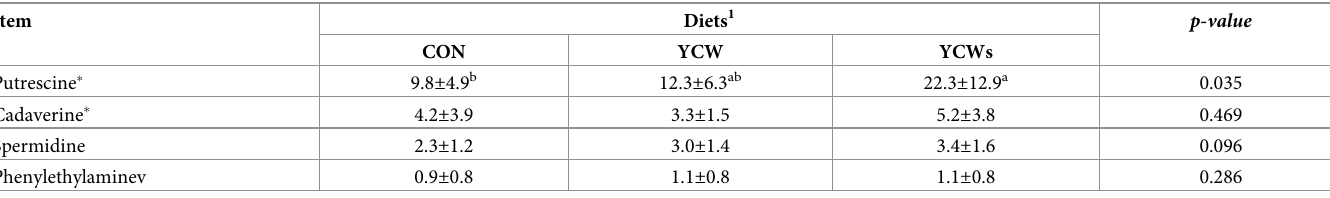
Table 6. Biogenic amines concentration (mg/100 g of dry matter) on the feces of dogs fed diets with the addition of different yeast cell wall preparations (mean and standard error of the mean).